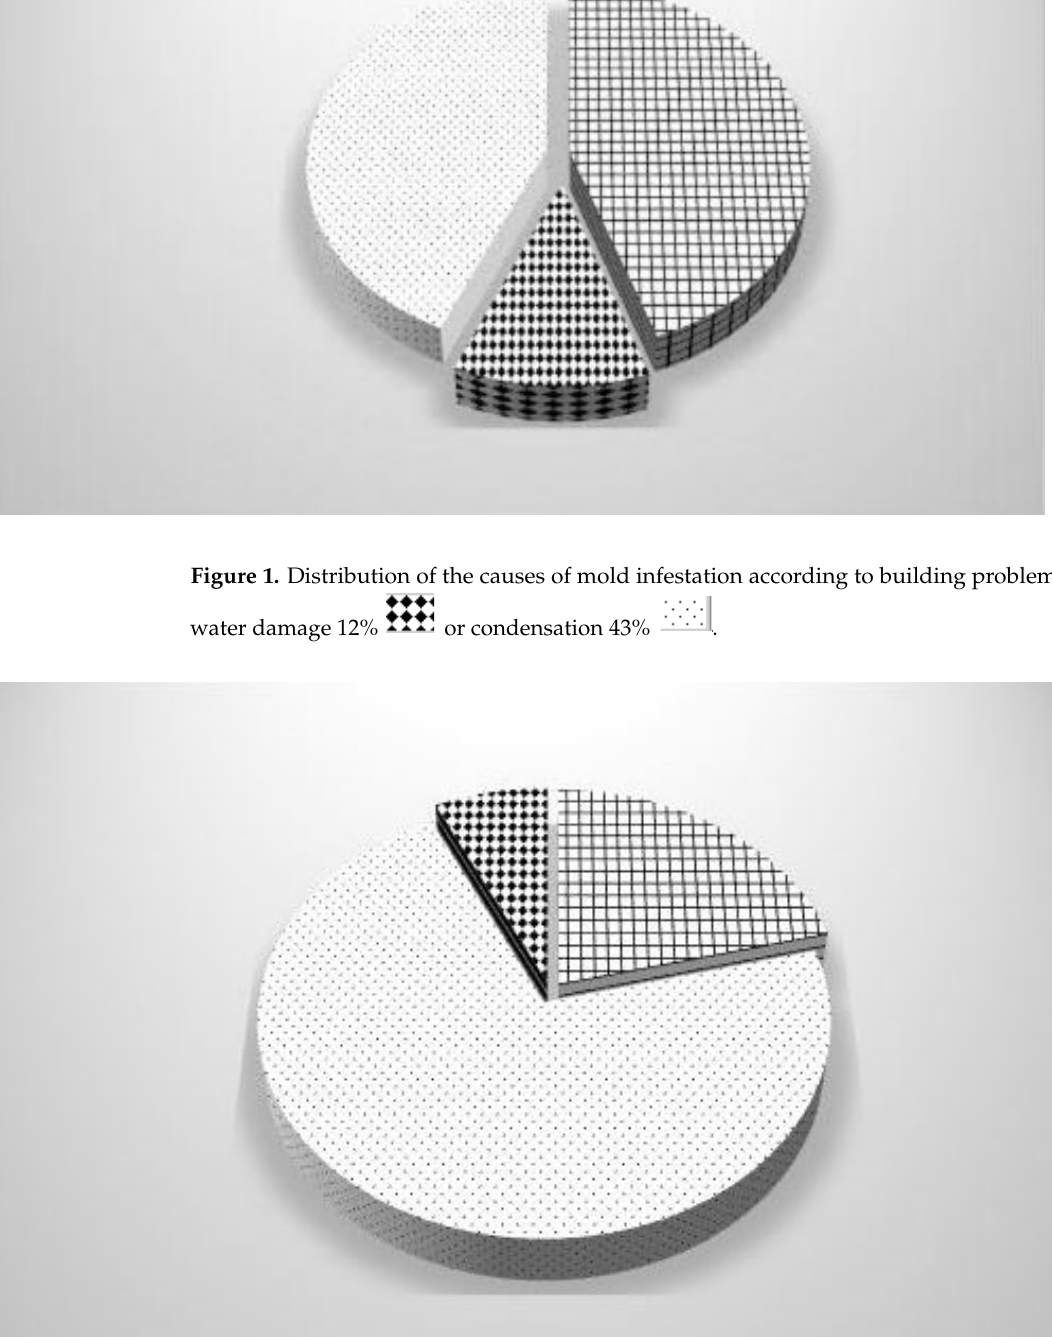
Figure 2. Distribution of building problems: damp rise 21% , water infiltration 72% or thermal bridge 7% .